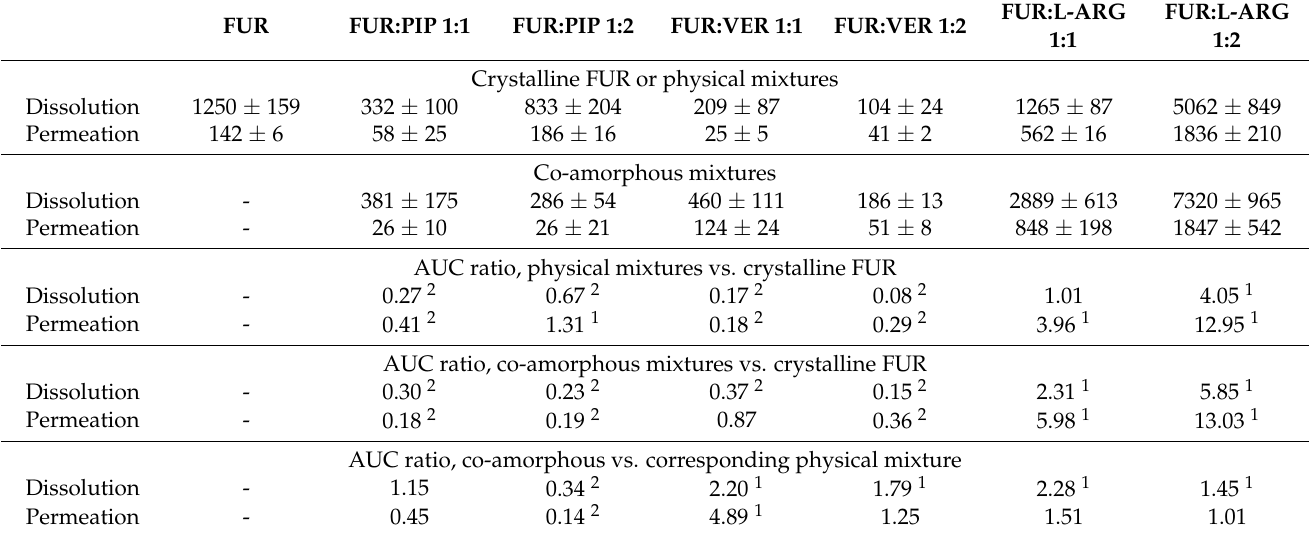
Table 3. Area under curve (AUC, mg * min) values for dissolved and permeated FUR during the 6 h dynamic dissolu- tion/permeation